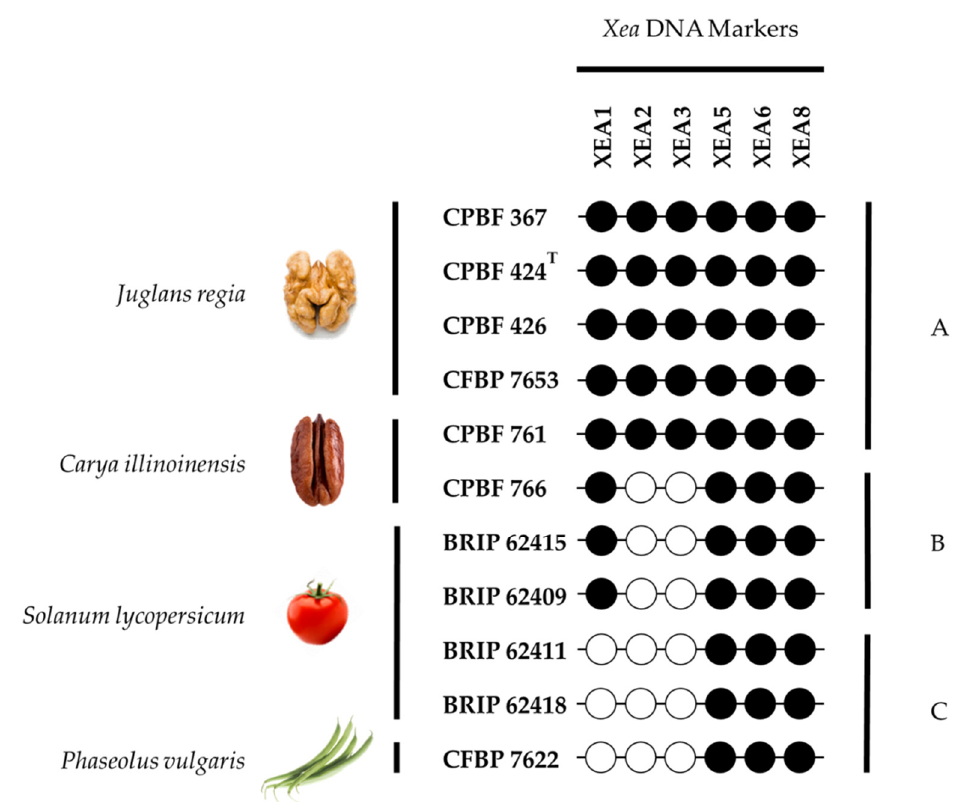
Figure 2. Distribution of six Xanthomonas euroxanthea (Xea) -specific DNA markers (XEA1, XEA2, XEA3, XEA5, XEA6 and XEA8) in 11 X. euroxanthea genomes. The presence/absence of six XEA DNA markers was assessed by BLASTn analysis in Geneious, allowing to disclose three patterns, A to C, that do not translate strain-host affinities.